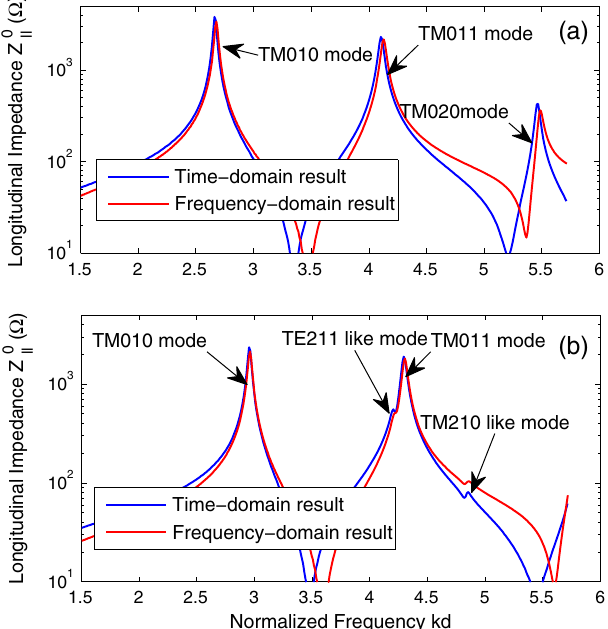
0 ∥ ; (b) dipole beam 30 to R= 10 , and